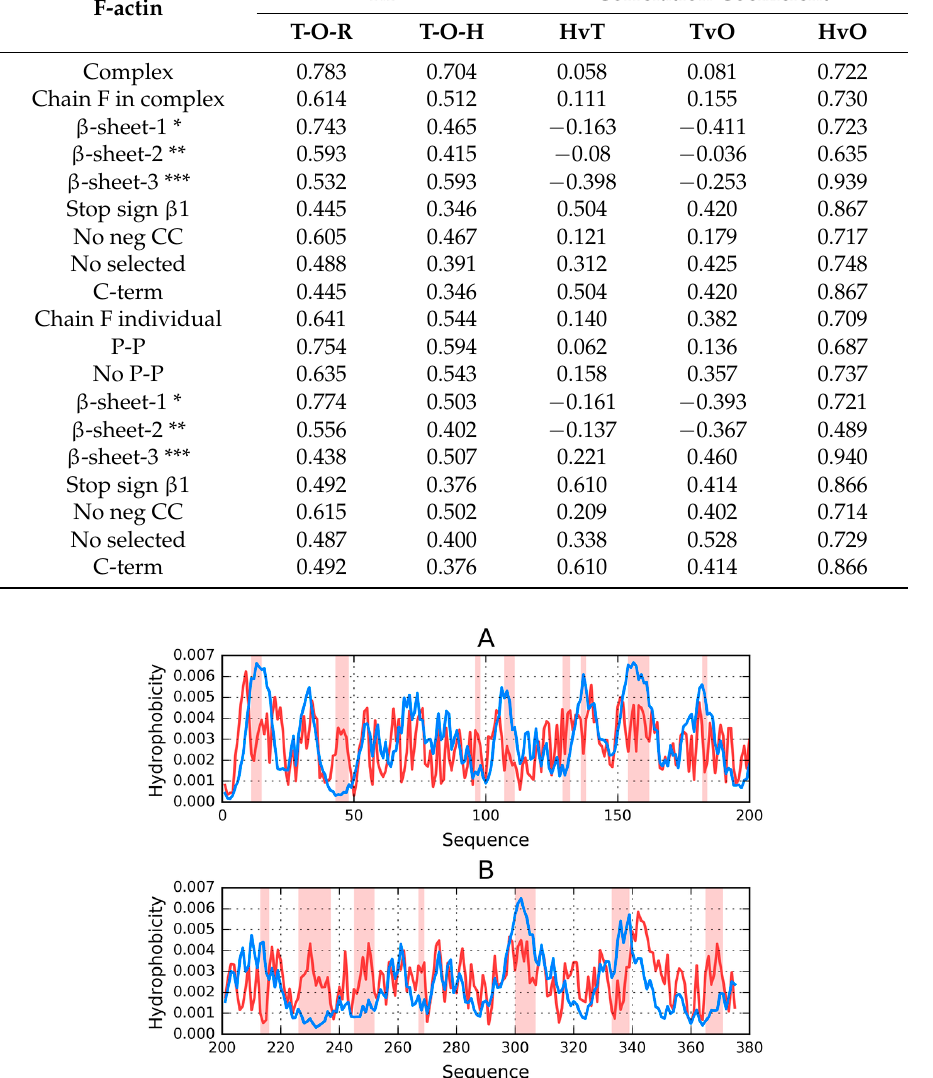
Figure 10. 3D presentation of F chain from F-actin (PDB ID 3J8I). Beta sheets are displayed in different shades of yellow. Red fragments distinguish residues that cause discordance between T